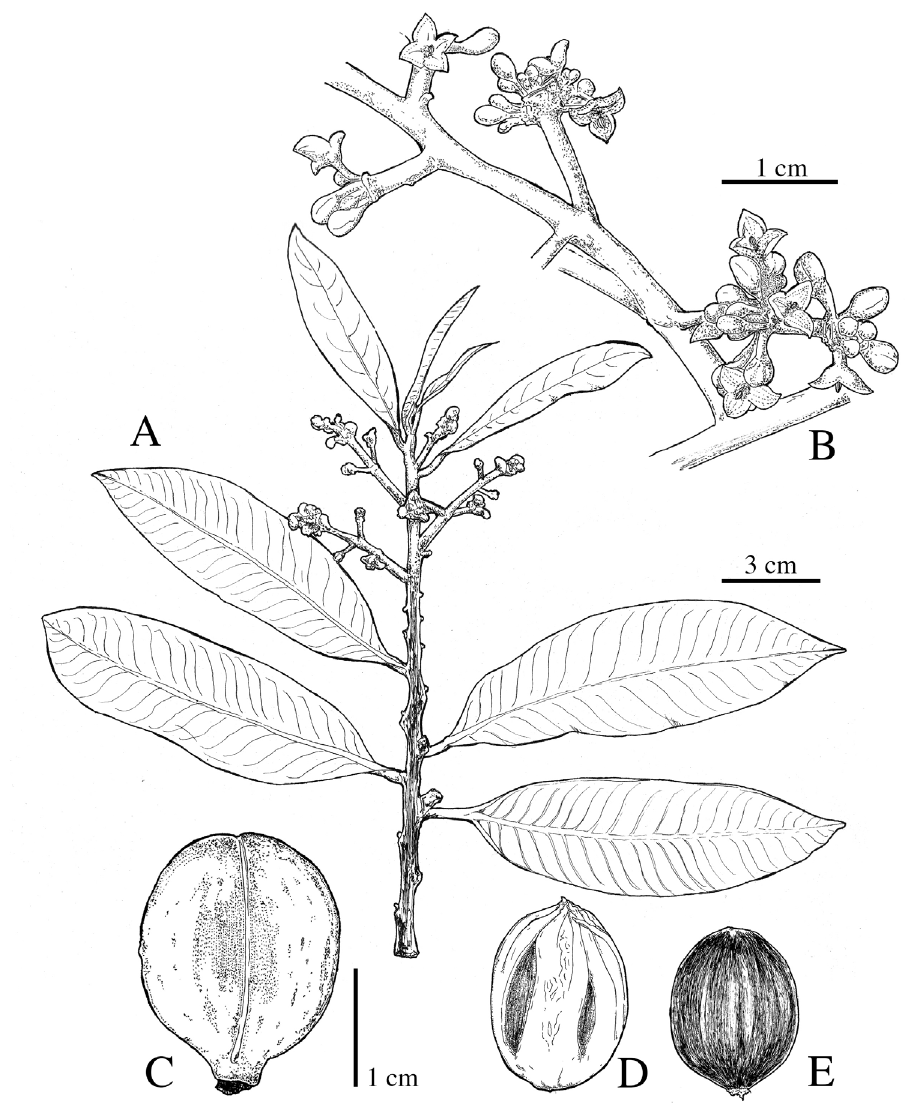
Figure 15. Virola fosteri A branch with leaves and inflorescences B partial inflorescences C fruit D seed with aril E seed. Drawn by Pedro Juarez, based on C. Galdames et al. 6422 ( A–E ). 0.15–0.38 cm. Fruits 1.5–2.3 × 1.2–1.8 cm, ovoid, sessile or very shortly stipitate, tomentose, the trichomes stellate, reddish-brown, the surface rugose when dry, the